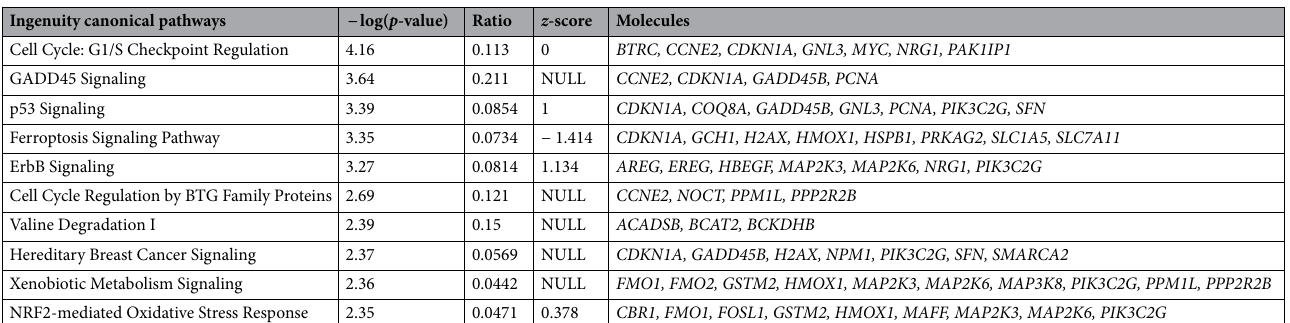
Table 1. List of top 10 canonical pathways for the common DEGs. DEG differentially expressed